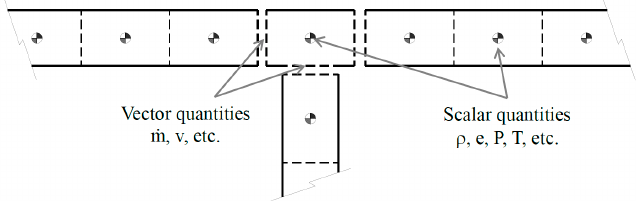
Figure 1. One-dimensional staggered grid formulation (courtesy of Gamma Technologies)